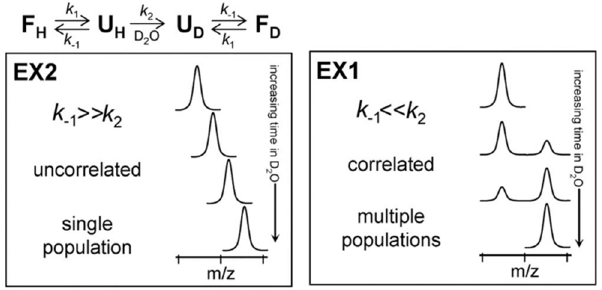
Figure 2. Protein unfolding kinetics and Hydrogen–Deuterium Exchange Mass Spectrometry (HDX-MS) at the top. The two possible mechanisms for hydrogen exchange in proteins, EX1 and EX2. Reproduced with permission from the Journal of the American Society for Mass Spectrometry (© 2006).